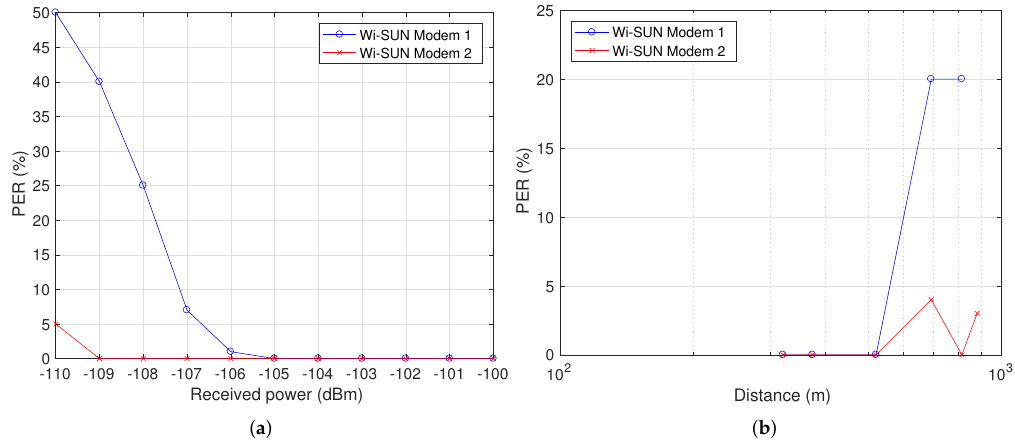
Figure 13. Packet error rate (PER) test of the Wi-SUN modems. ( a ) Receiver sensitivity experiments. The sensitivities are < − 107 dBm at PER < 10%. ( b ) PER test of the LOS experiment of Figure